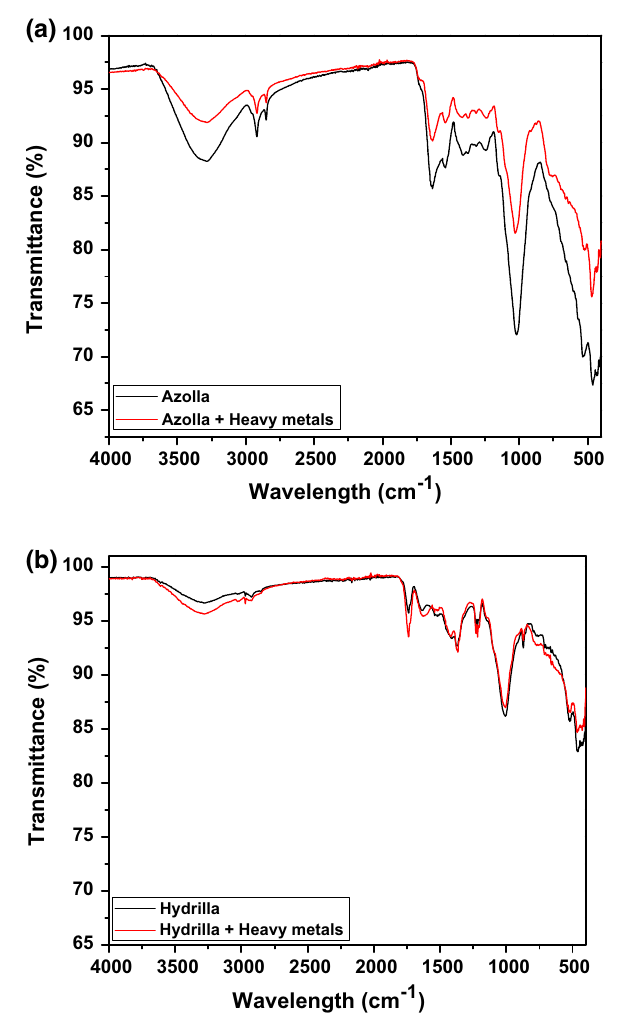
Fig. 3 FTIR spectra of the control biosorbent and metal-loaded biosorbent a Azolla filiculoides and b Hydrilla